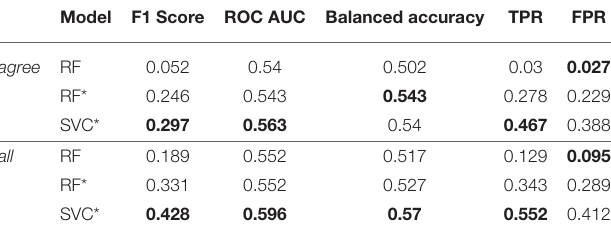
TABLE 4 | Scores for all relevance prediction models trained and evaluated with data collected based on the Google NQ corpus. Model F1 Score ROC AUC Balanced accuracy